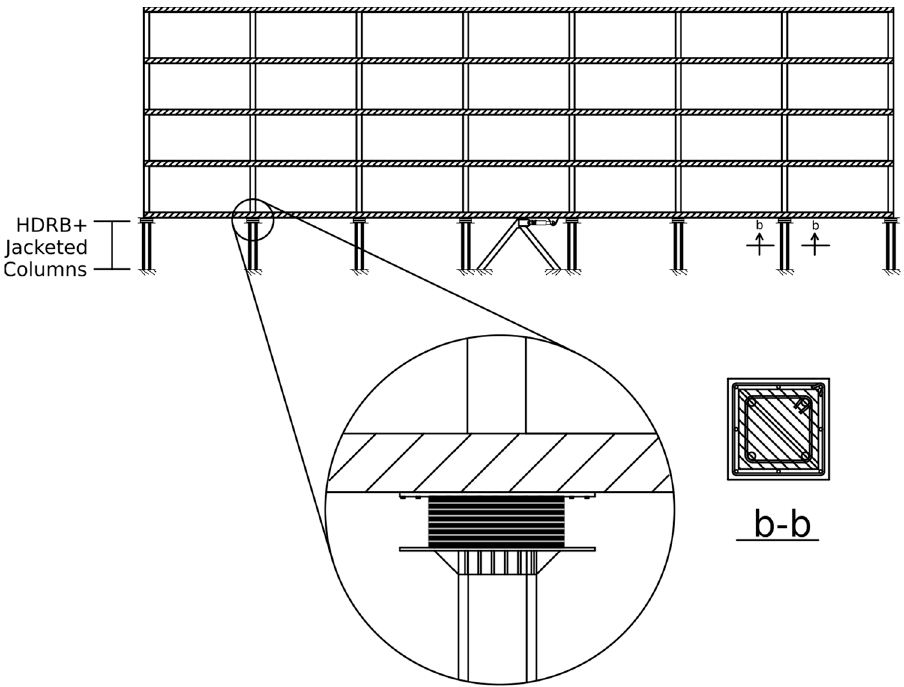
Figure 3. High-damping rubber bearing base isolation with viscous fluid damping devices (Case 3).